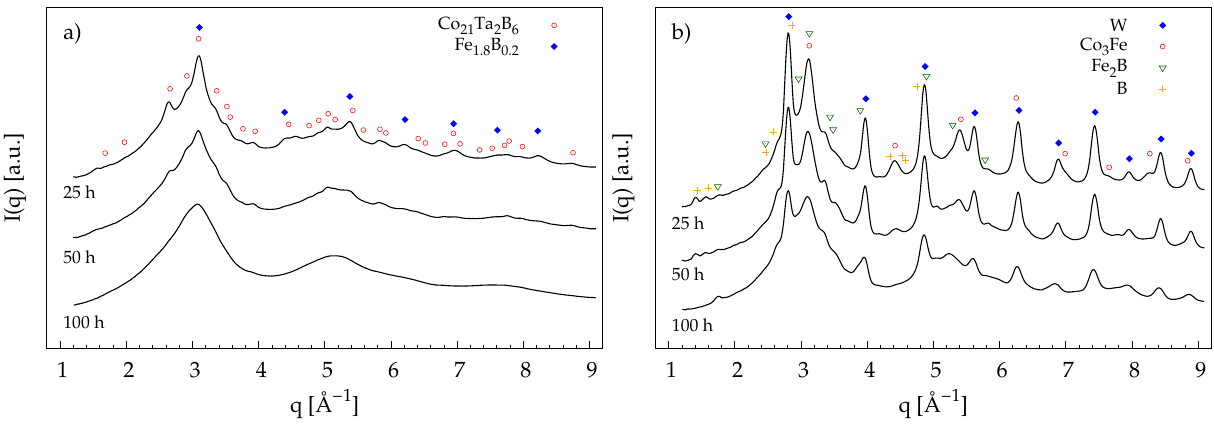
Figure 1. X-ray diffraction patterns I ( q ) for ( a ) CoFeTaB alloy and ( b ) CoFeWB alloy after 25, 50 and 100h of mechanical alloying. For a better clarity curves are plotted in logarithmic scale and are vertically offset. Various symbols denote positions of Bragg peaks stemming from respective crystallographic